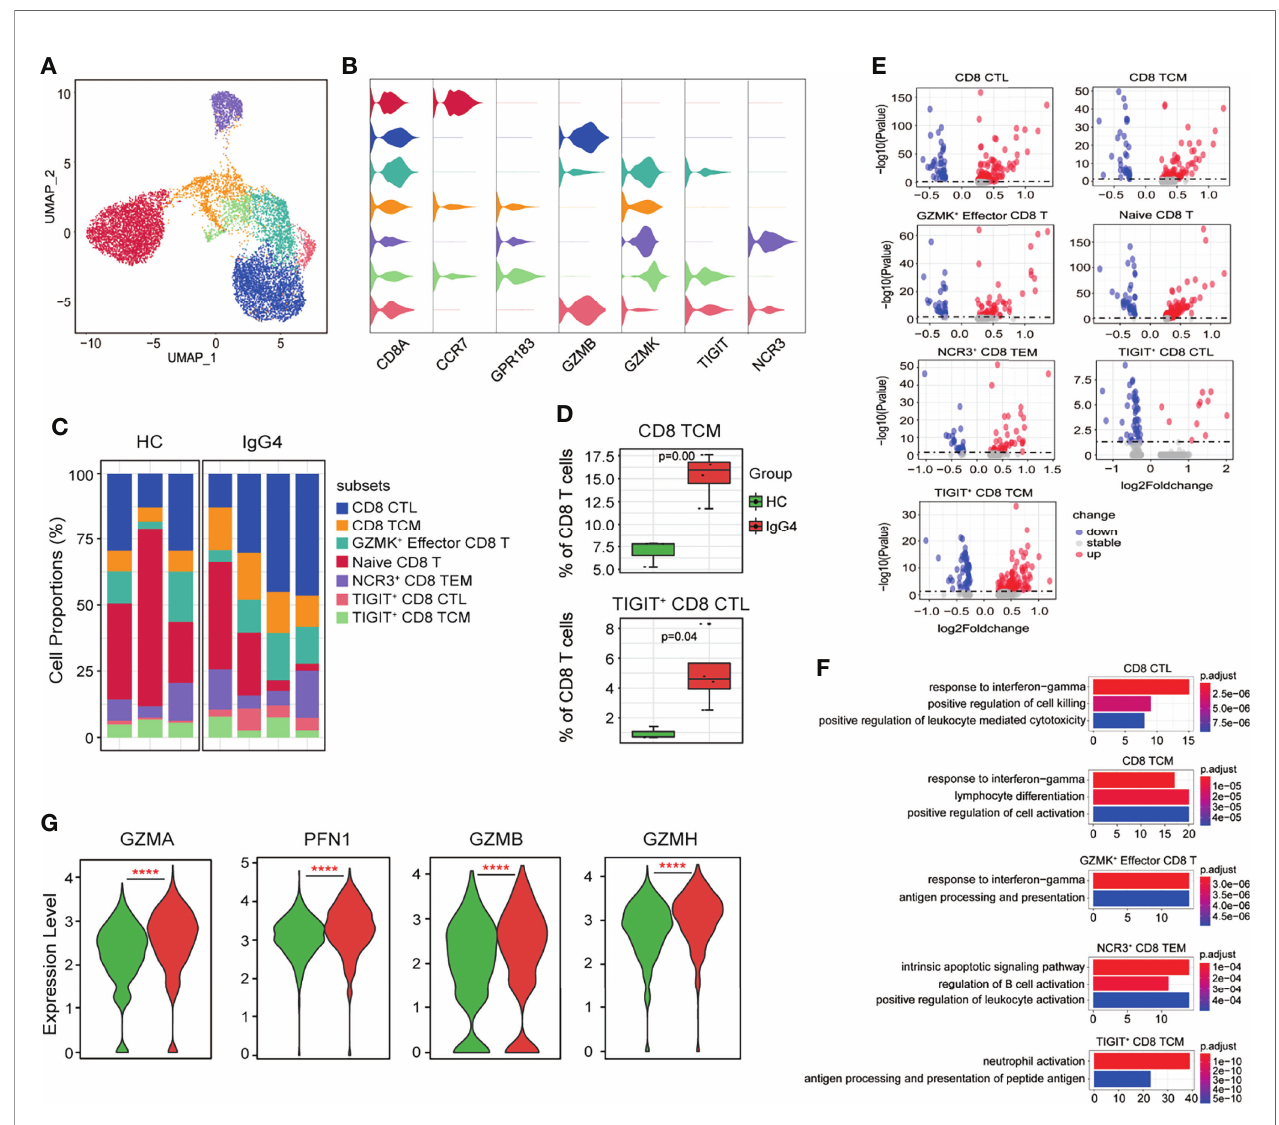
FIGURE 5 | The heterogeneity and transcriptional features of CD8 T-cell subsets in IgG4-RD. (A) UMAP representation of 11,864 CD8 T cells, showing the formation of seven clusters. (B) Violin plots showing expression distribution of canonical cell markers. (C) Bar plot showing cluster abundance of each CD8 T-cell type across all samples. (D) Percentages of two types of CD8 T-cell between HCs and IgG4-RD. The y -axis shows the average percentage of CD8 T-cell subtypes in total CD8 T cells. Error bars are shown in mean ± SEM. Student t -test was used for the analysis, and P < 0.05 is considered as a signi fi cant difference. (E) Volcano plot showing the DEGs of CD8 T-cell subtypes between HCs and patients with IgG4-RD. (F) Violin plots showing expression of GZMA , PFN1 , GZMB , and GZMH in CD8 CTL. (G) GO analysis showing the biological process enriched in different CD8 T-cell subtypes of patients with IgG4-RD, ****P <